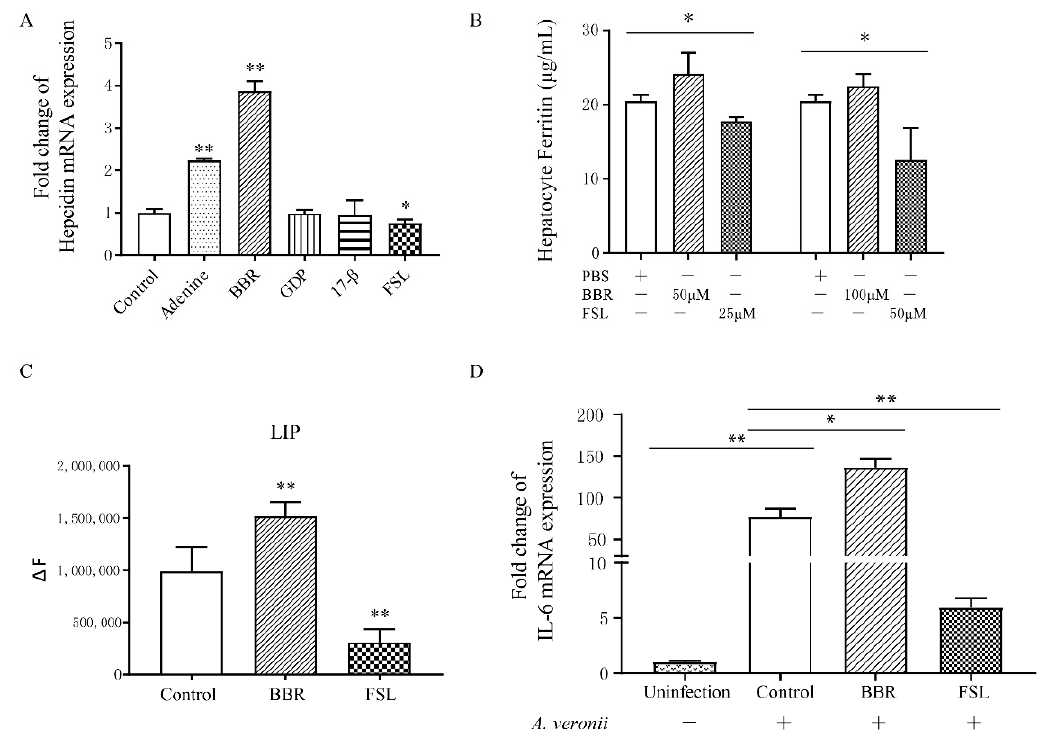
Figure 3. BBR and FSL regulate hepcidin as agonists and antagonists in P. fulvidraco hepatocytes. ( A ) Effects of Adenine, BBR, GDP, 17- β , and FSL on the mRNA level of hepcidin in hepatocytes. ( B ) ELISA of the ferritin protein level of after incubation of hepatocytes with different concentrations of BBR and FSL. ( C ) Fluorescence detection of LIP level after incubation of hepatocytes with BBR and FSL. ( D ) qRT-PCR assay of mRNA level of IL-6 after 6 h incubation of BBR or FSL with hepatocytes followed by 3 h infection with A. veronii . * p < 0.05; ** p < 0.01 versus control.